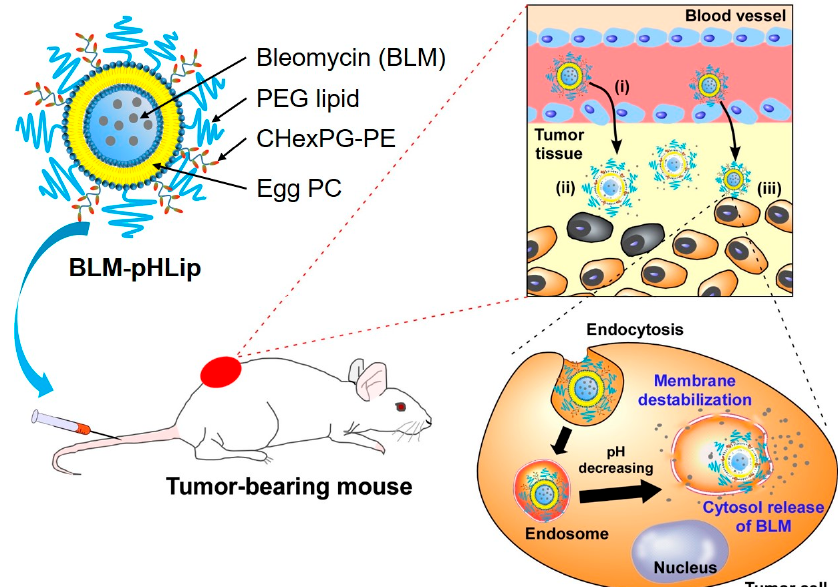
Figure 1. Design of bleomycin (BLM)-loaded pH-sensitive liposomes modified with poly(ethylene glycol) for intracellular drug delivery. ( i ) Accumulation of liposomes to tumor tissue via Enhanced Permeation and Retention (EPR) effect. ( ii ) BLM release responding to weakly acidic pH at tumor tissue. ( iii ) Some liposomes are taken up by tumor cells and release the drug in response to endosomal pH.